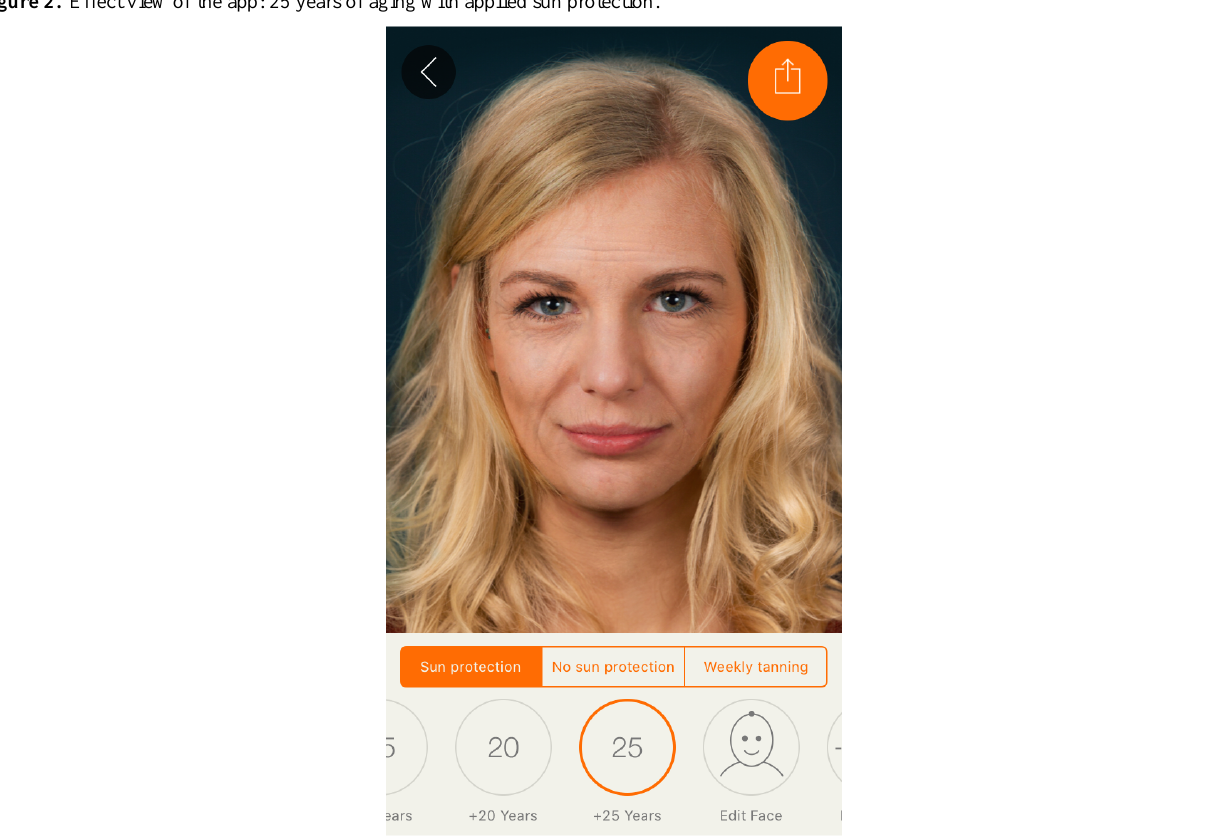
Figure 2. Effect view of the app: 25 years of aging with applied sun